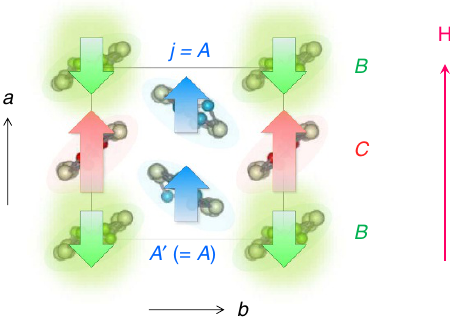
Figure 6 | Ferrimagnetic spin polarization. Schematic illustration of the ferrimagnetic spin polarization suggested at low temperatures (below 60K) by our site-selective susceptibility measurements. Thick arrows represent the direction of the local magnetic field on the non-equivalent site A ( ¼ A ’), B and C in the unit cell, which is opposite to the external field direction ( H || a in this figure) at the site B while it is parallel at all other